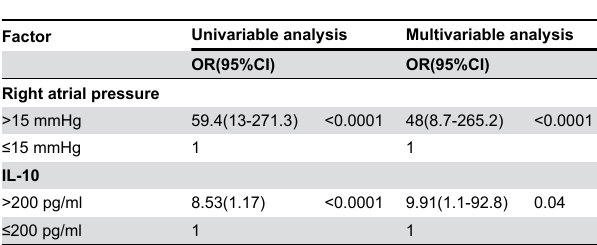
Table 3. Univariable and multivariable logistic regression analysis for factors associated with effusive constrictive pericarditis.